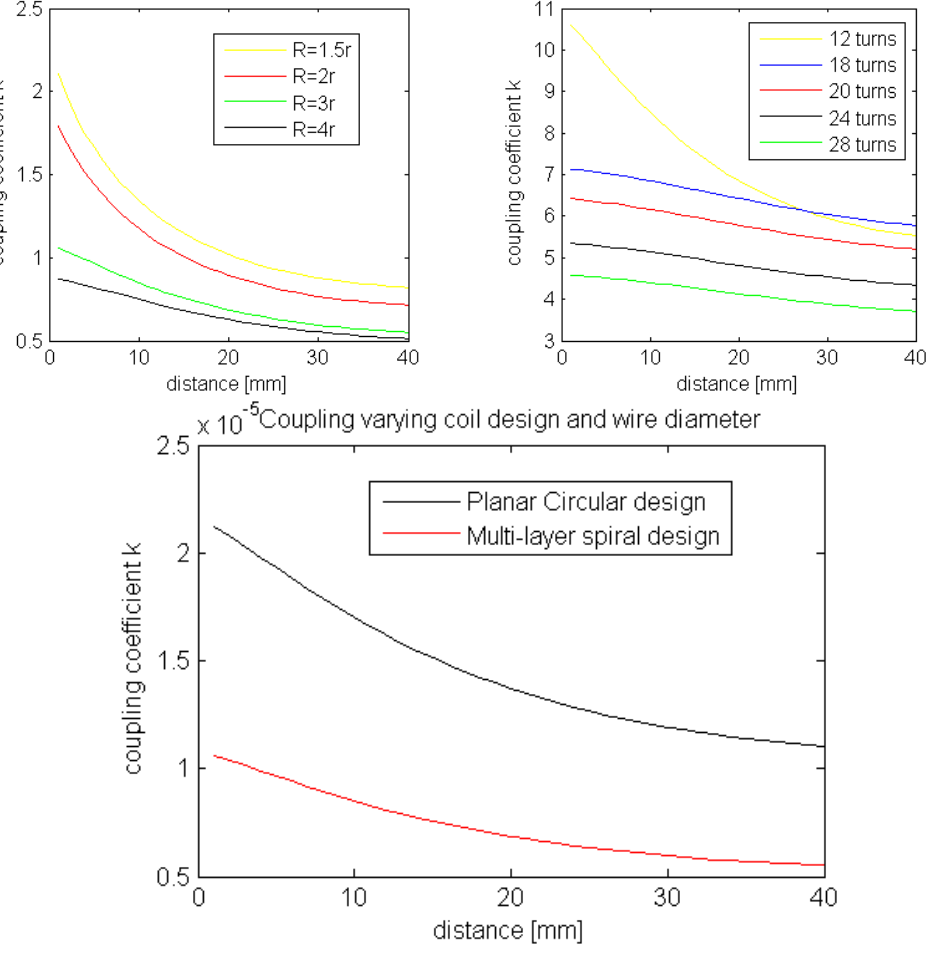
Figure 6. Trends of k depending on the distance between the two coils by varying: external radius keeping the number of turns constant ( Top - Left ); number of turns keeping the external radius constant ( Top - Right ); coil design ( Bottom